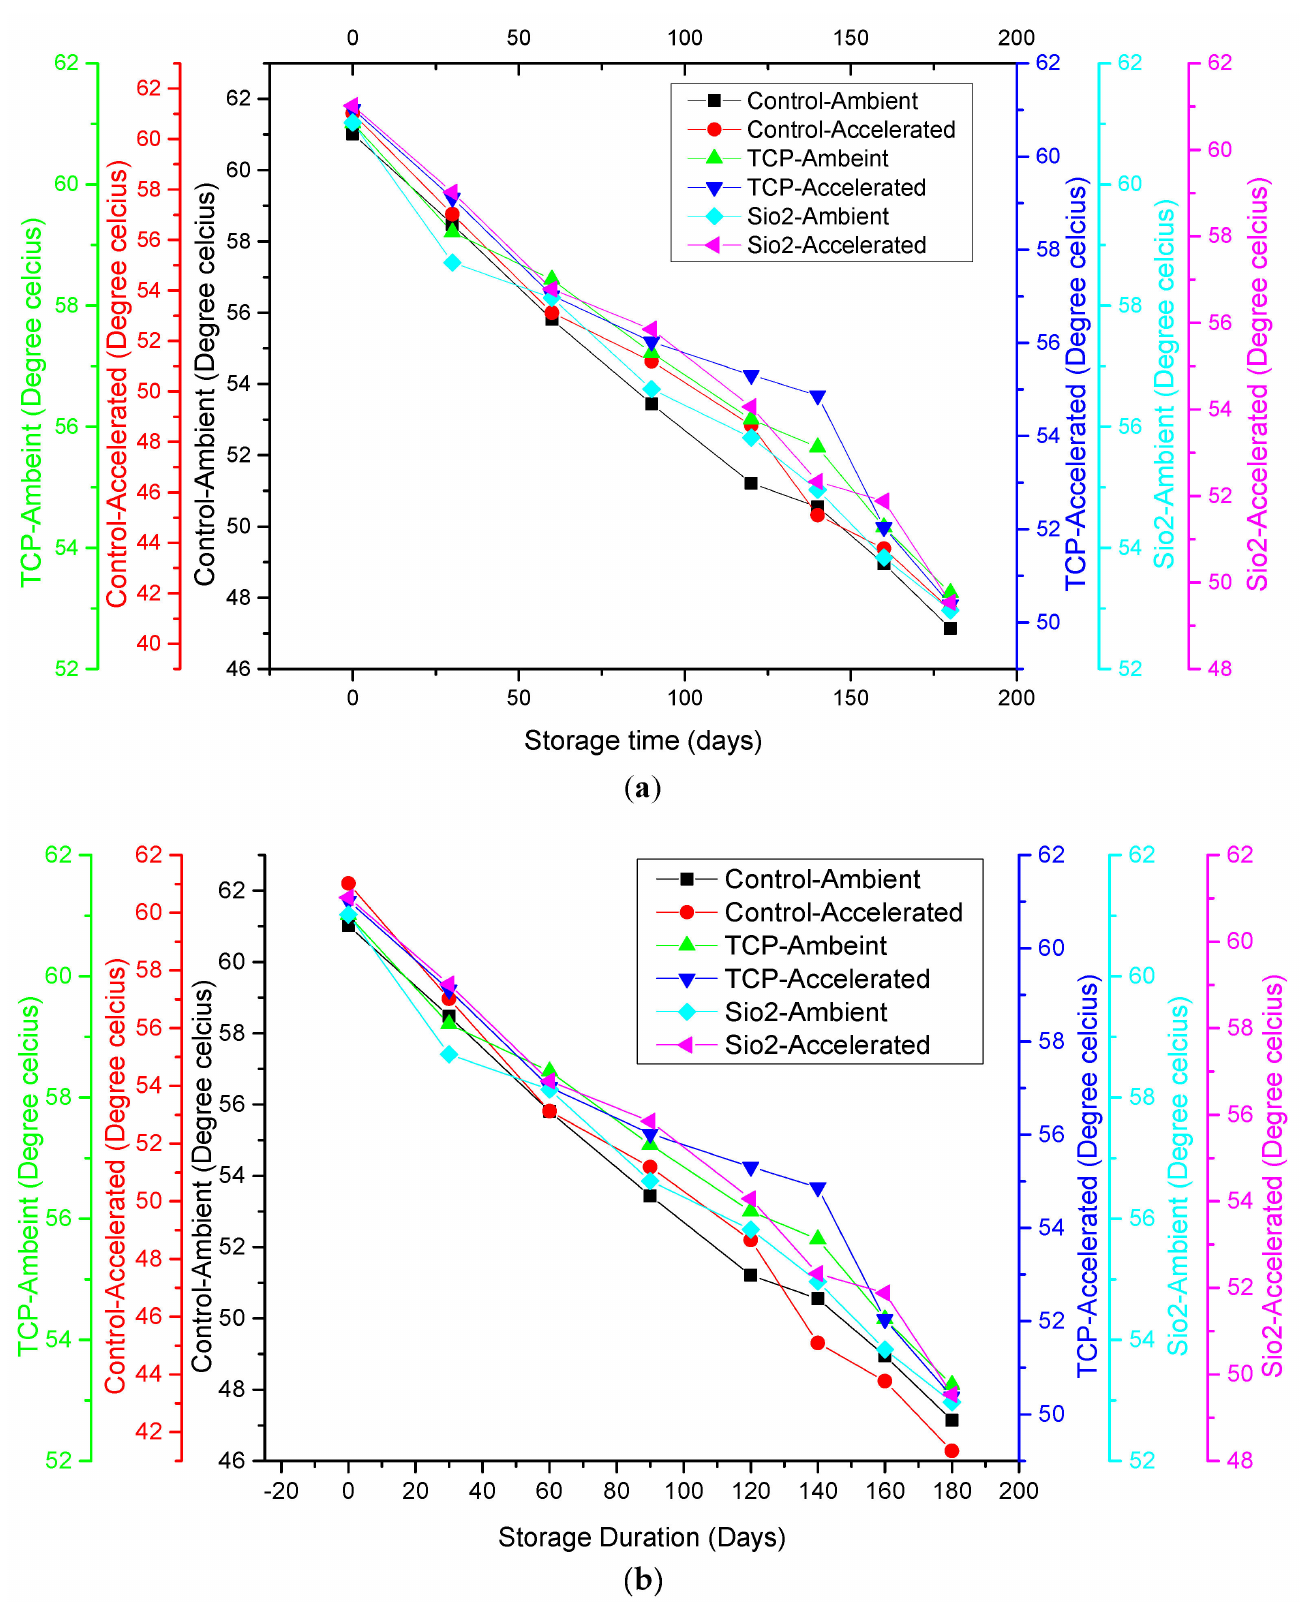
Figure 2. Relationship between ( a ) moisture gain and glass transition temperature of control and SDAP under ambient and accelerated storage conditions; ( b ) moisture gain and sticky-point tempera- ture of control and SDAP under ambient and accelerated storage